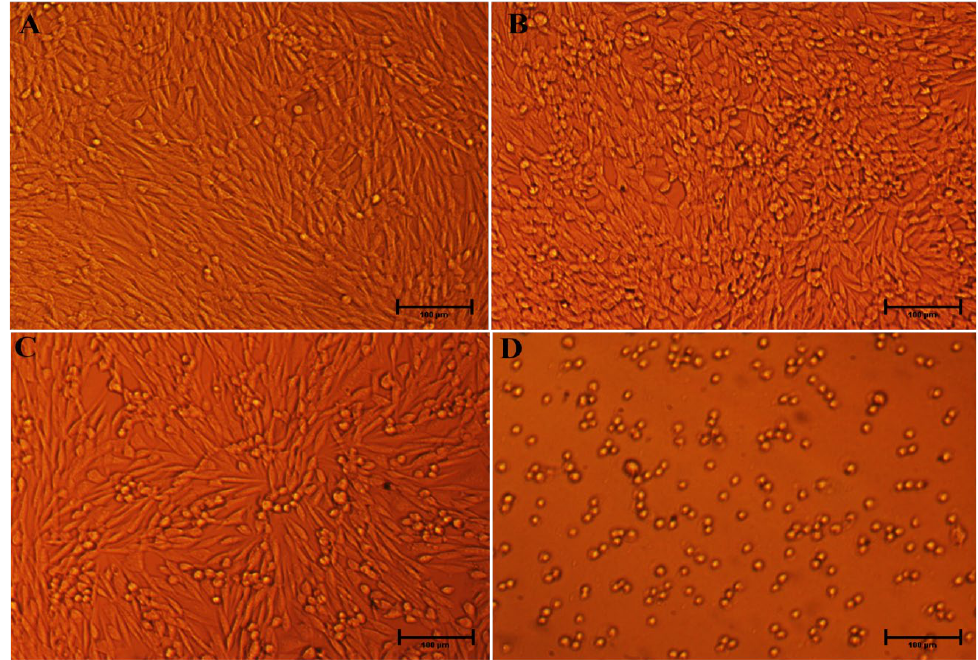
Figure 11. The morphological representation of the HCT-116 cells treated with different concentration of Ag-C-3 ( A ) Control HCT-116 cells; ( B – D ) treated with 5, 10 and 20 μg/mL. Scale bar 100 μm.